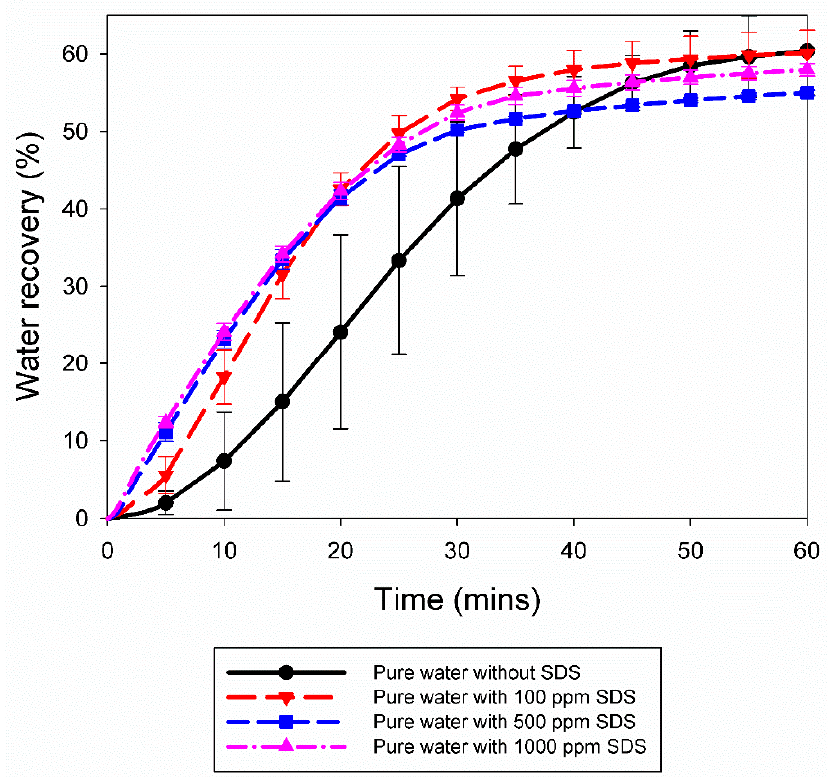
Figure 6. Effect of sodium dodecyl sulfate (SDS) concentration on water recovery in pure water with the 10% propane in argon gas mixture.